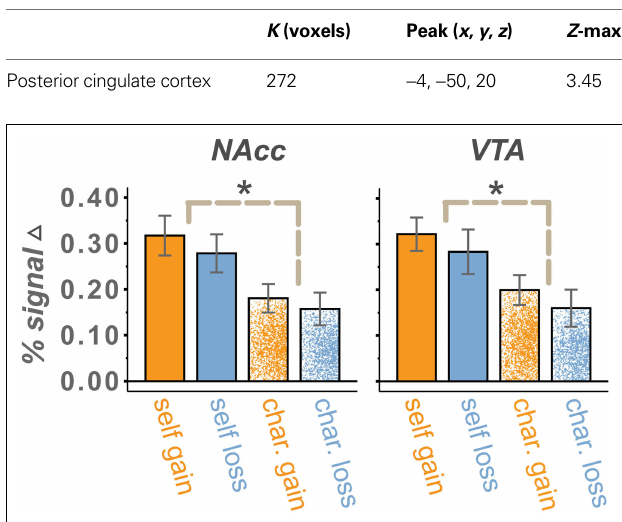
Table 7 | Charity-Lose $4 > Self-Lose $4.